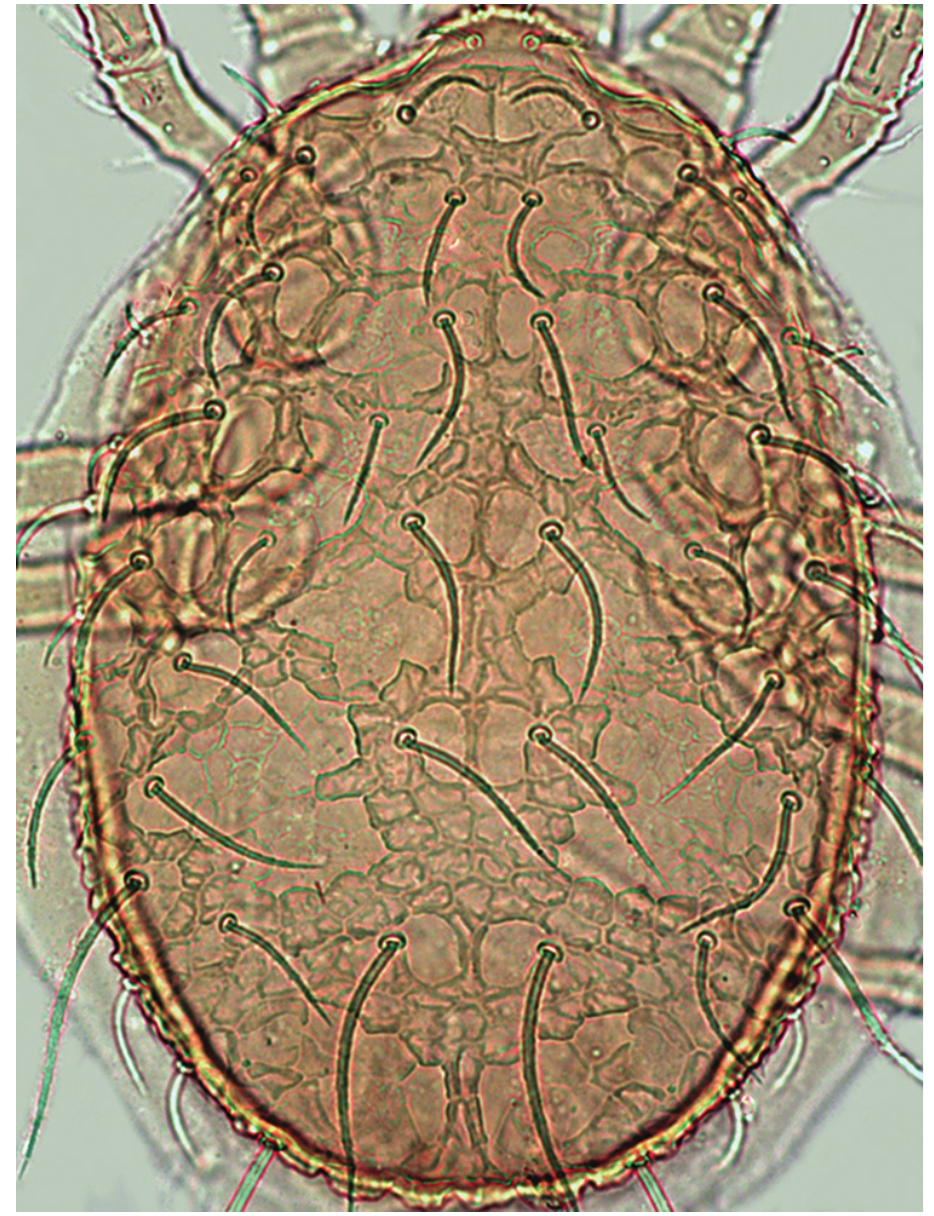
Plate 15. Ameroseius furcatus , female, dorsal idiosoma (pressed